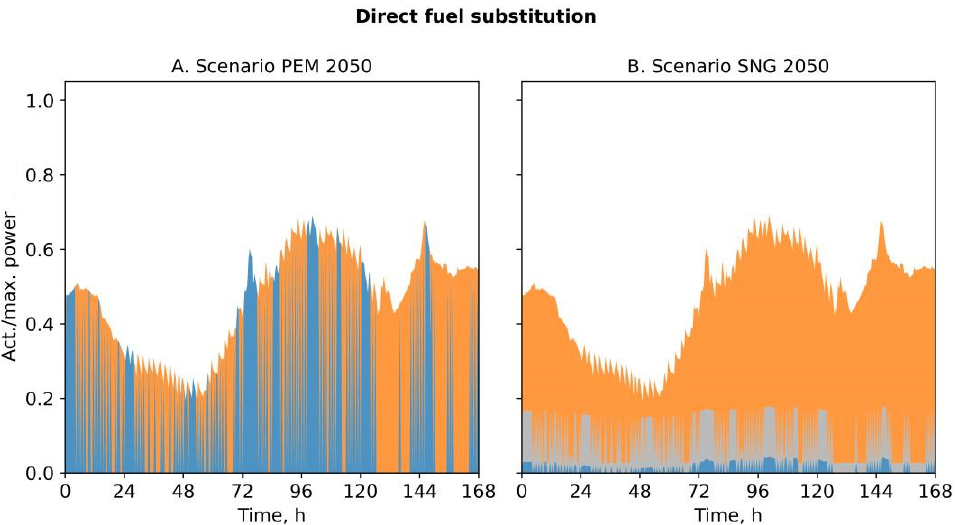
Figure 9. Substitution of natural gas (orange) by hydrogen (blue) and SNG (grey) for the scenarios PEM 2050 ( A ) and SNG 2050 ( B ). Table 7. Reduction of internal (scope 1) and external (grid) CO 2 emissions.